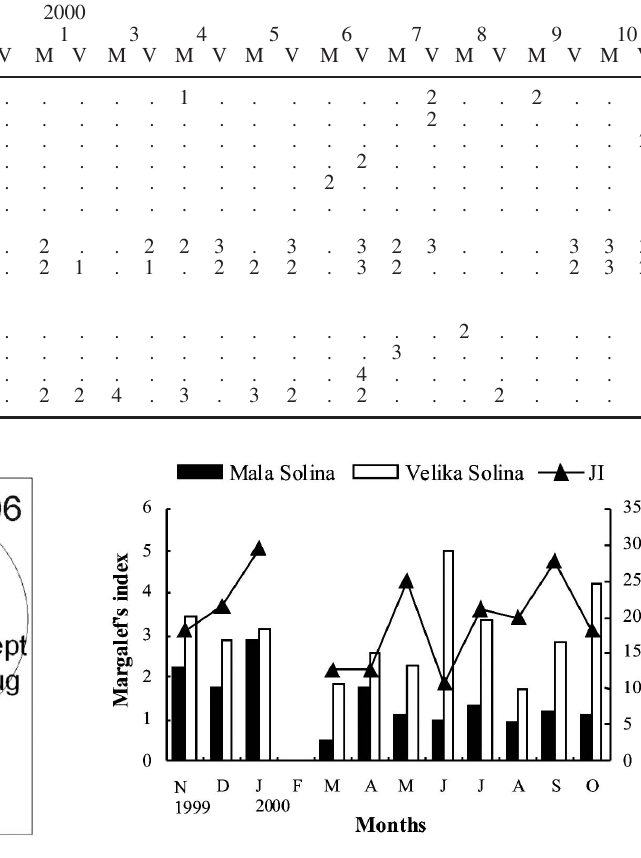
Fig . 8. – Margalef’s species richness index in Mala Solina and Velika Solina, and Jaccard’s similarity index between the lakes’